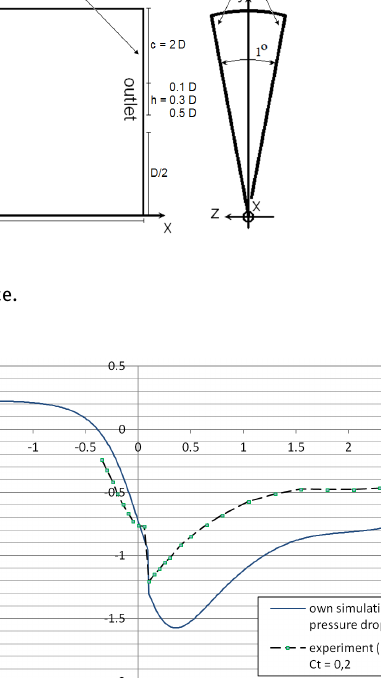
Figure 8: Streamwise distribution of pressure coefficient for experi- ment in [11] and own CFD